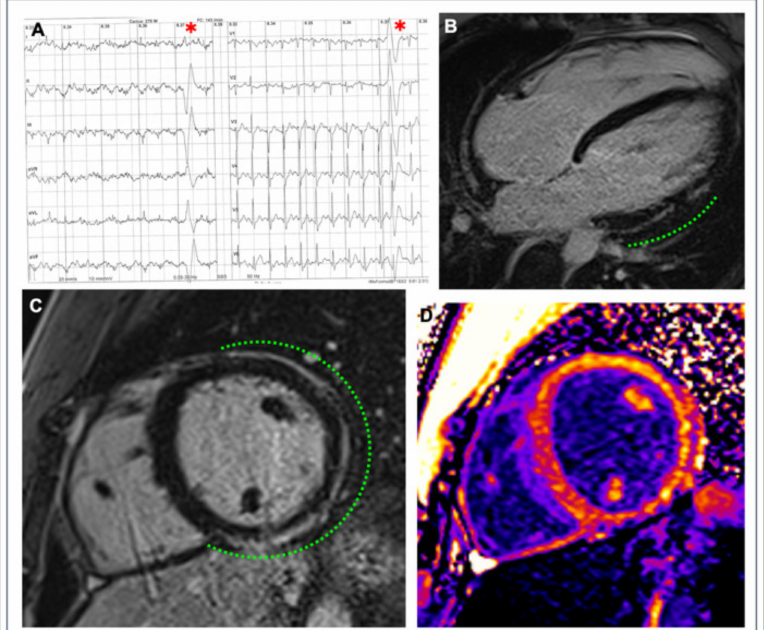
Figure 2. A 26-year-old competitive hockey player presented with frequent PVBs with right bundle branch block/superior axis morphology at high workload during exercise testing (( A ), red asterisks). Post-contrast sequences on CMR revealed a subepicardial stria of LGE with a “ring-like” pattern, involving the anterior, lateral and inferior LV walls in their basal and medium portions (green dotted line; ( B ) 4-chamber view; ( C ) short-axis view); the presence of fibrous tissue is also confirmed by the increased signal in the correspondent areas in the native T1 mapping short-axis sequence ( D